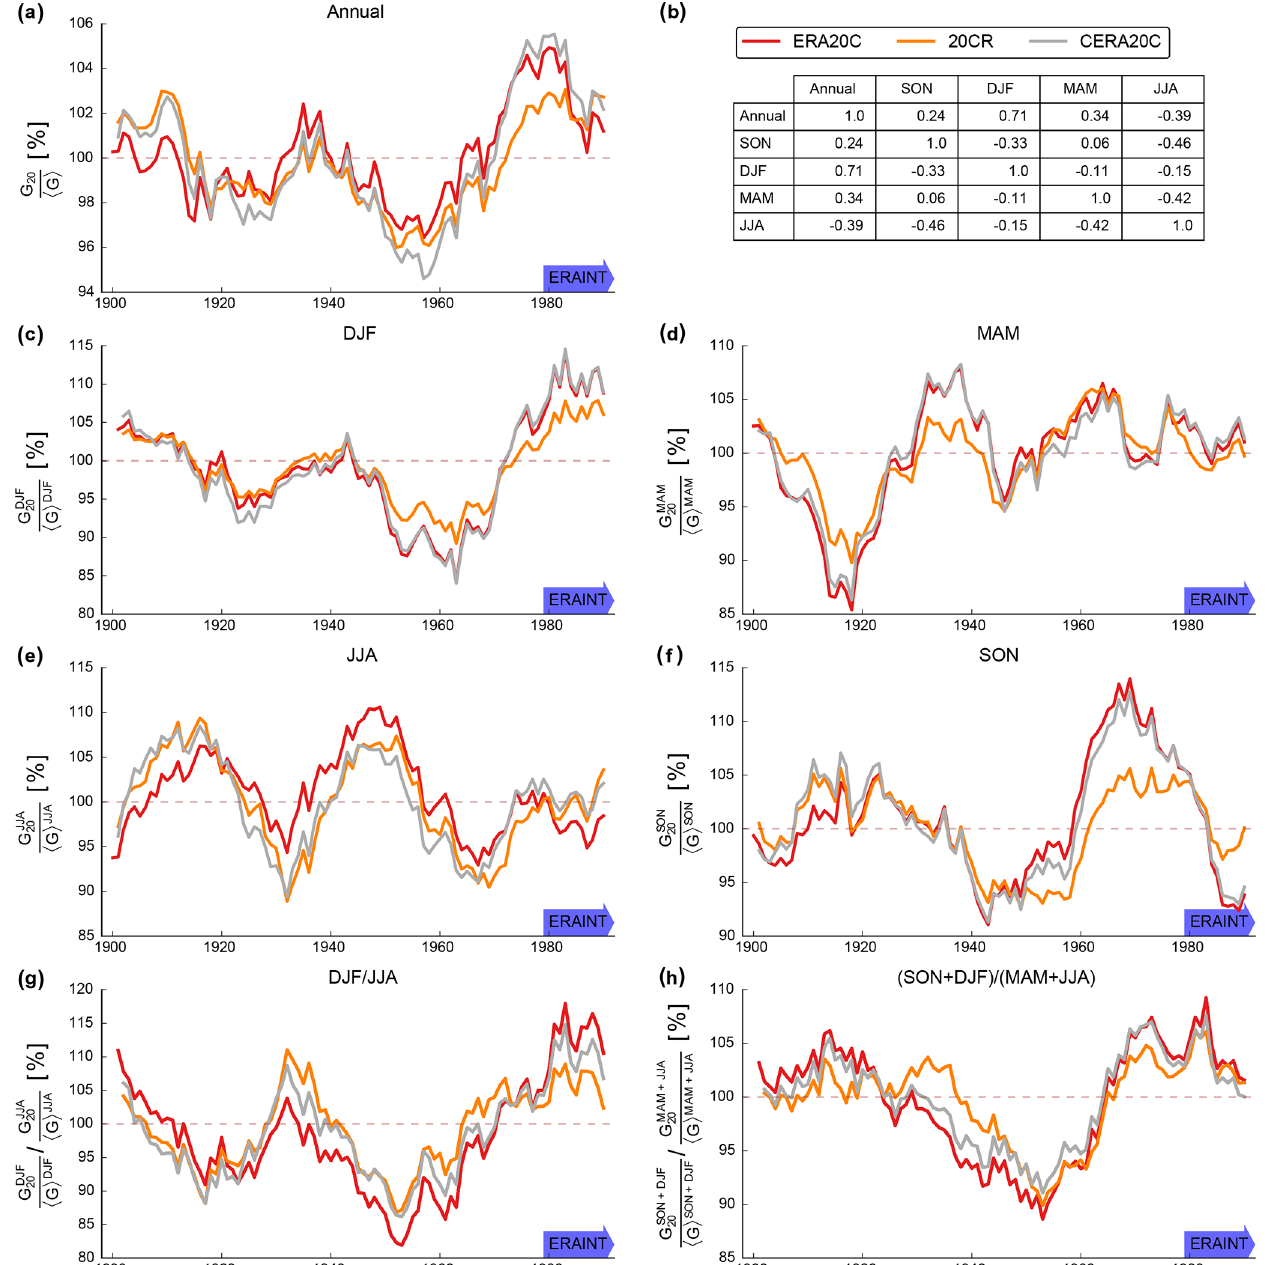
Figure 3. Normalized lifetime generation from German wind parks. Time series are based on detrended 20th century reanalyses. The panels show annual (a) and seasonal (c–f) time series. Different versions of the seasonality are also displayed (g–h) and correlations between seasons are reported for ERA20C (b) . The data have been smoothed by application of a running mean 20-year forward filter (i.e., the reported value for 1900 is the average of the years 1900–1919). The blue arrow highlights the limited coverage of ERAINT.